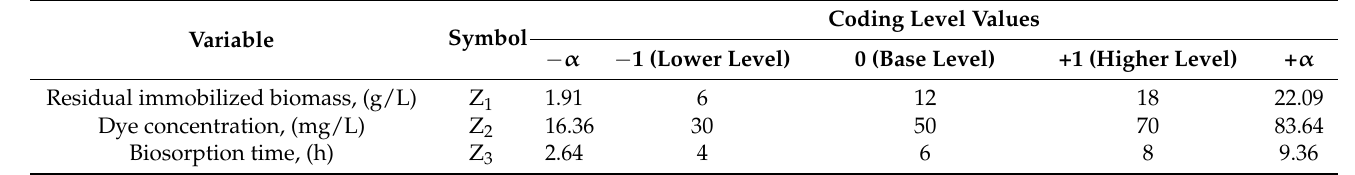
Table 2. The coding level of the variables and the actual values used to design the experiments.